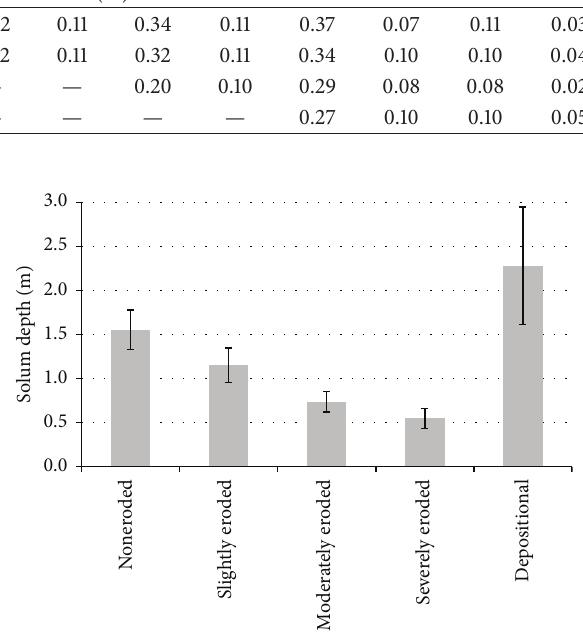
Figure2:Meandepthandstandarddeviationofsoilsolum(Ap-BC) of the studied